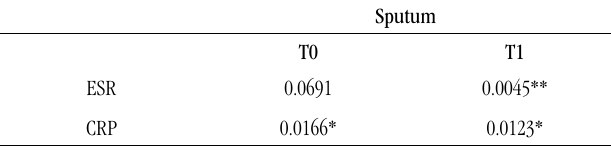
tABLE 2 – Comparison of positive/negative sputum p -value versus altered/normal ESR and CRP at T0 and T1, by Fisher’s method Sputum T0